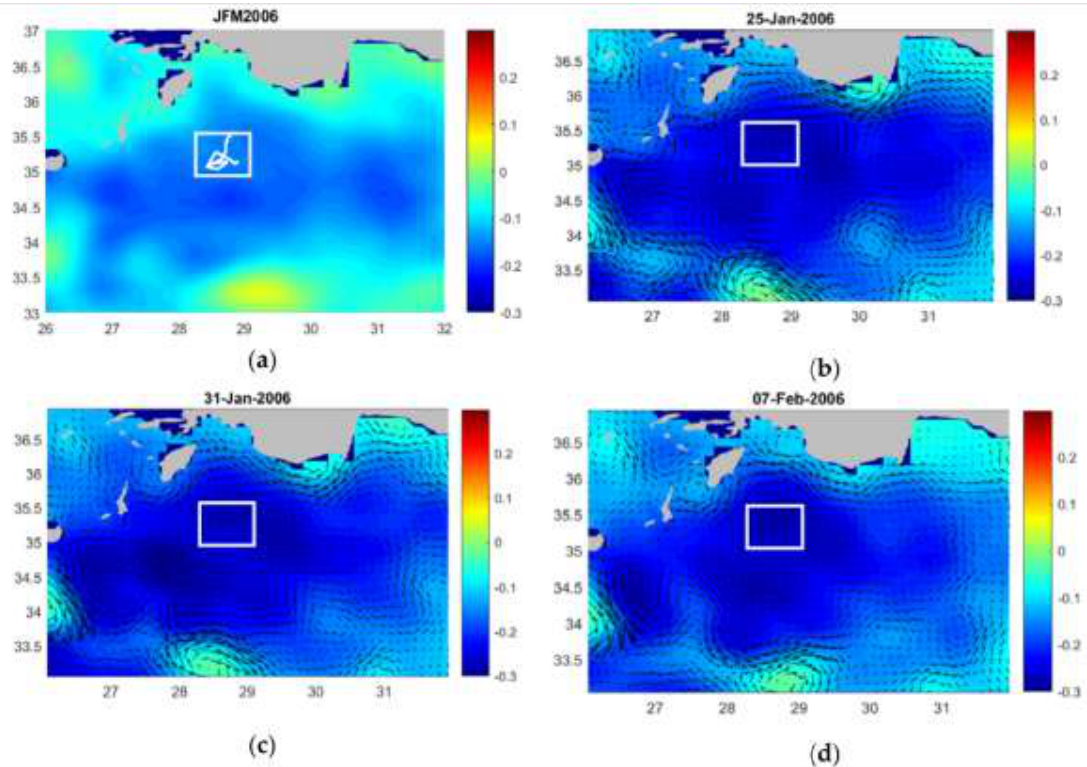
Figure 9. ( a ) Trajectory of float WMO 6900098 depicted within white rectangle overlaid on mean SSH (m) for JFM 2006 for the NWLS. ( b–d ) daily SSH (m) during the LDW convection events (from